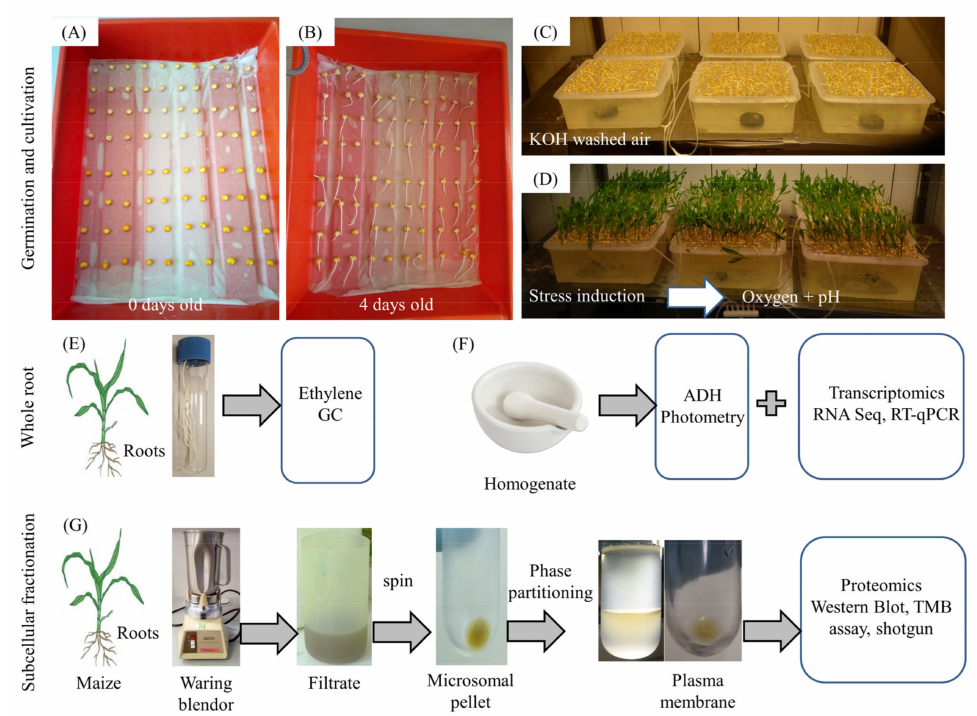
Figure 1. Experimental design. ( A ) Sterilized and soaked caryopses were placed onto wetted tissue and incubated in the dark at 26 ◦ C for four days. ( B , C ) The seedlings were transferred to 9 L trays with a culture medium and cultivated in a climate chamber with constant oxygen supply. ( D ) After 14 days, hypoxia stress was induced by adding commercially available rape oil to the culture medium. After 24 h, oxygen and pH were measured and roots of control and stressed plants were sampled. ( E ) Maize roots of control and stressed plants were used to measure ethylene by gas chromatography. ( F ) Maize root extracts of control and stressed plants were used to measure ADH activity and to perform transcriptomic analyses. ( G ) Maize roots of control and stressed plants were used to prepare subcellular fractions (soluble fractions, microsomes, and plasma membranes) for proteomic analysis. For more details, see